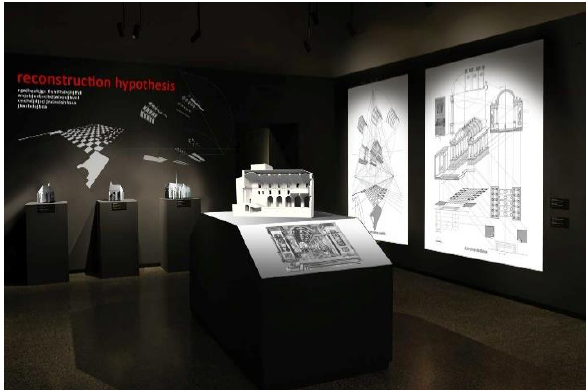
Figure 5. Virtual exhibition. One of the hypothesis of drawn architecture reconstructions (virtual exhibition by